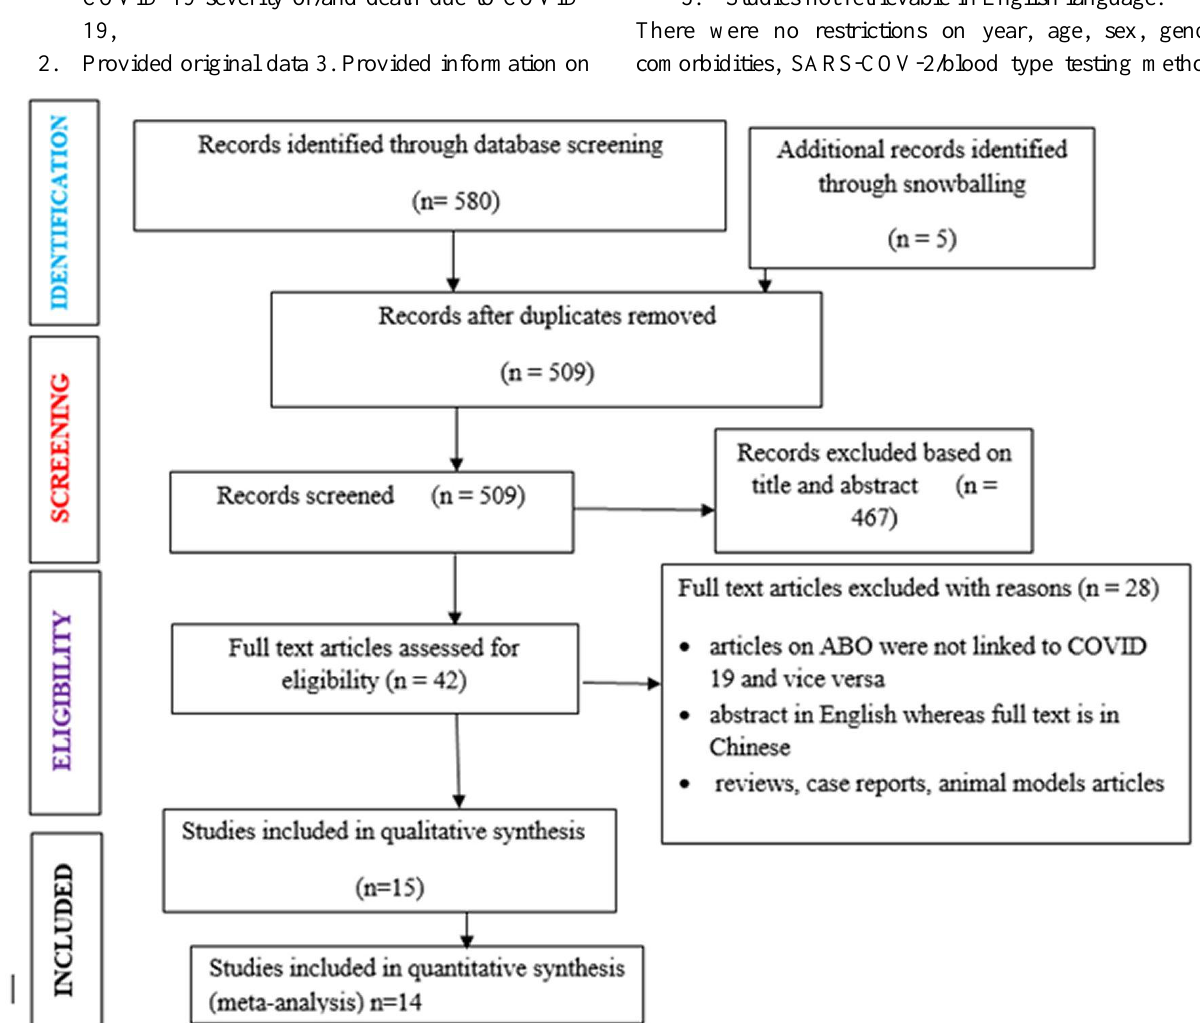
Figure 1 : PRISMA flow chart showing study selection